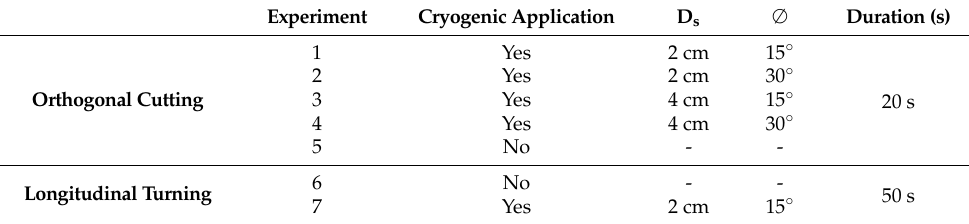
Table 2. Design of